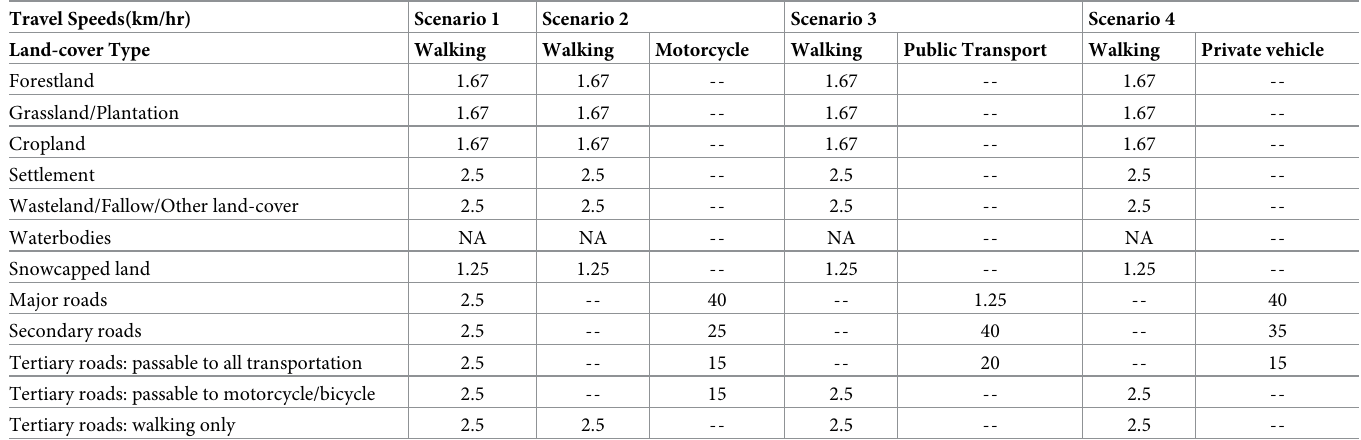
Table 1. Travel scenario representing travel speeds, per land-cover type.